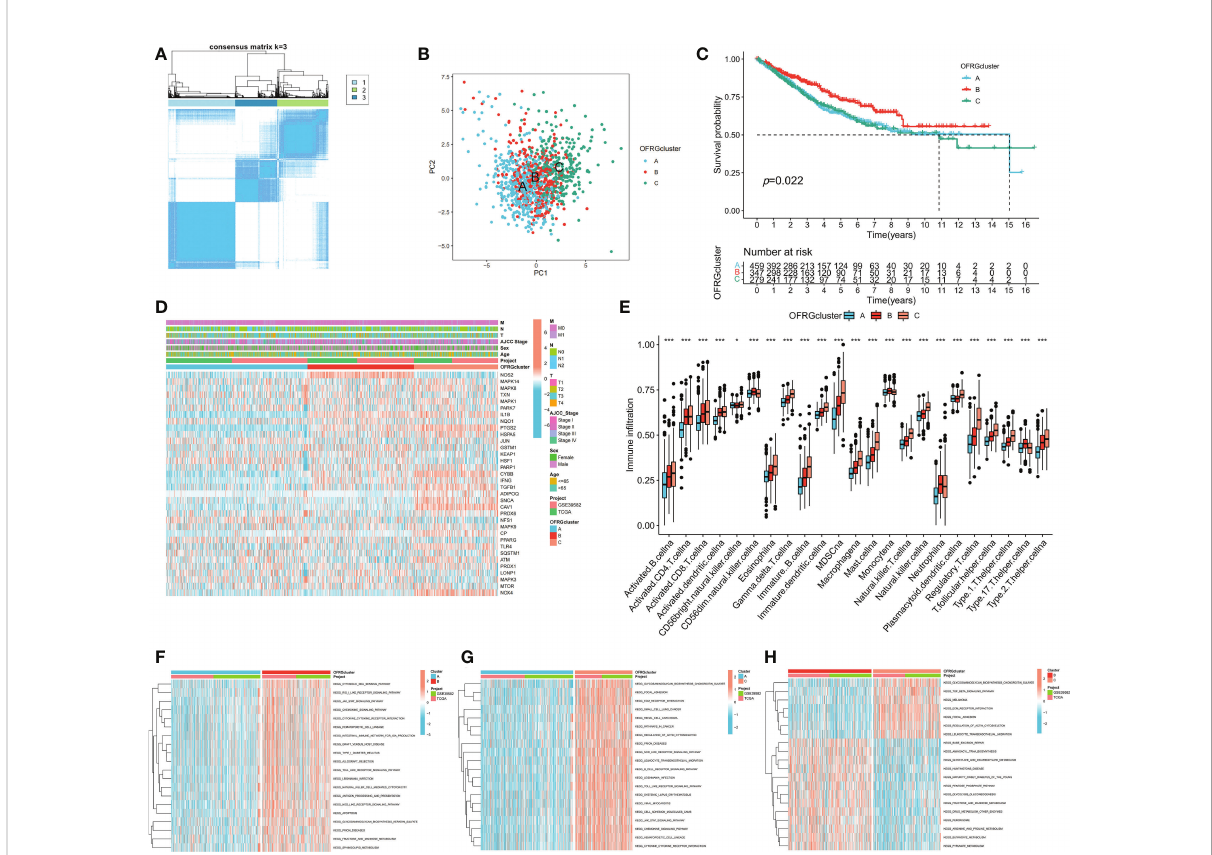
FIGURE 2 OFRG clusters and clinical characteristics, tumor microenvironment between CRC samples in OFRG clusters. (A) Three OFRG clusters were de fi ned using consensus clustering analyses. (B) PCA showed the distinction between three OFRG clusters. (C) The KM curve revealed signi fi cant difference in the survival time between the three clusters ( p = 0.022); (D) Heatmaps showed the relationship between OFRG clusters and clinical features and OFRGs expression in patients with CRC. (E) ssGSEA investigated the differences of immune cell in fi ltration between OFRG clusters. (F – H) GSVA showed the enriched pathways between each two OFRG clusters. * p < 0.05, *** p <